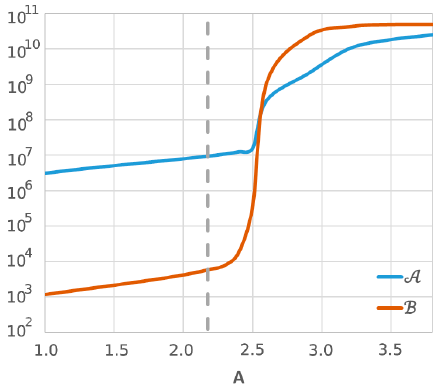
Figure 2. Change in nonlinear coefficients 𝒜 and ℬ as a function of the change in input amplitude, A. Coefficients increase dramatically above the Blake threshold.